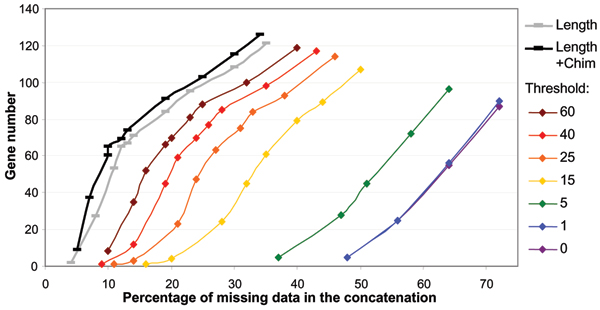
Evolution of missing data according to the threshold. For seven threshold values defining the maximal in-OTU/out-OTU distances ratio, the number of selected genes is plotted against the percentage of missing sites in the concatenated file. Subsets are extracted from the Metazoa dataset without making of chimera. The evolution of missing data is also displayed when the selection is only made according to the size criterion (black and grey curves respectively with and without making of chimera); these last selections represent the minimal amount of missing data for the dataset.